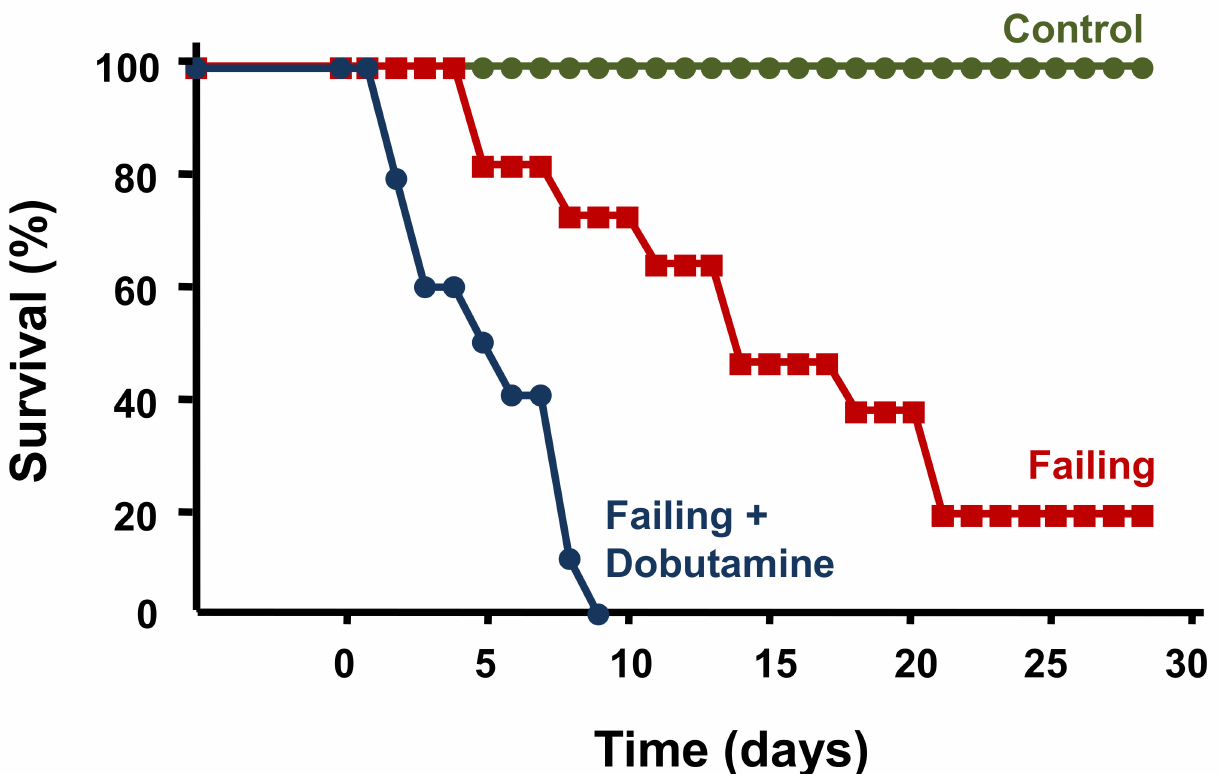
Figure 3. Dobutamine effect on survival. Heart failure was induced in rats by banding the aorta. Dobutamine is a catecholamine that acts on α 1 , β 1 , and β 2 adrenergic receptors. Stimulation of these receptors by dobutamine produces a relatively strong inotropic effect. Treatment by dobutamine resulted in a significantly higher and earlier mortality rate. This demonstrates the negative impact of increased inotropy in the treatment of heart